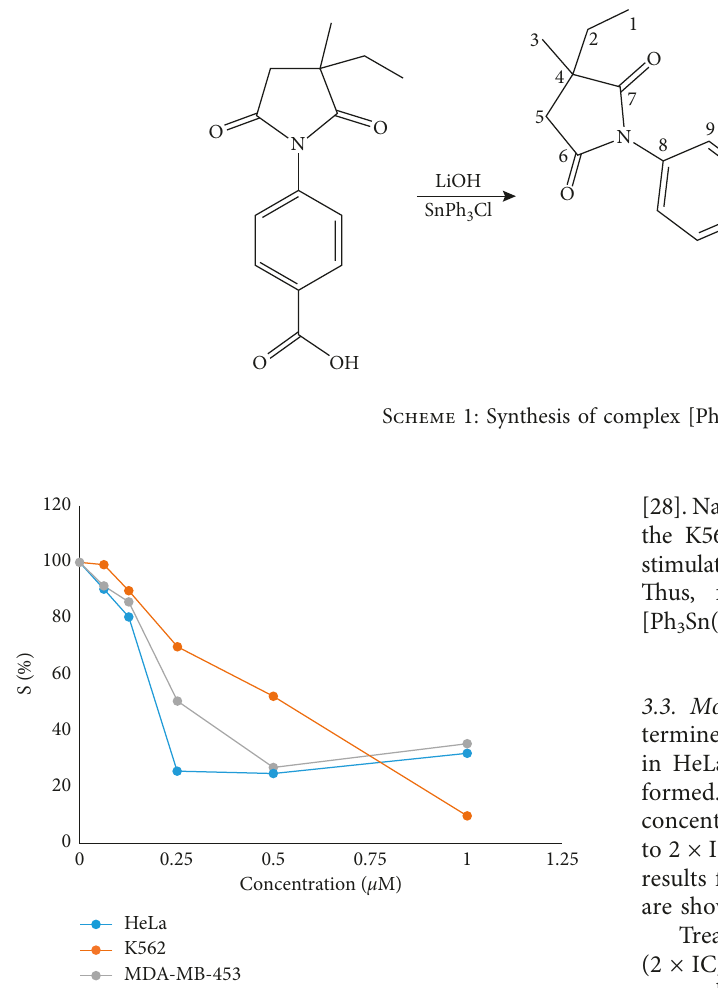
Figure 1: Survival of tumor cells as a function of different con- centrations of [Ph 3 Sn(CEMPD)] determined by MTT test, after 72h incubation. Table 1: IC SD) of CEMPDH, [Ph 3 Sn(CEMPD)], 50 ( µ M) (mean and cisplatin (72h of ±